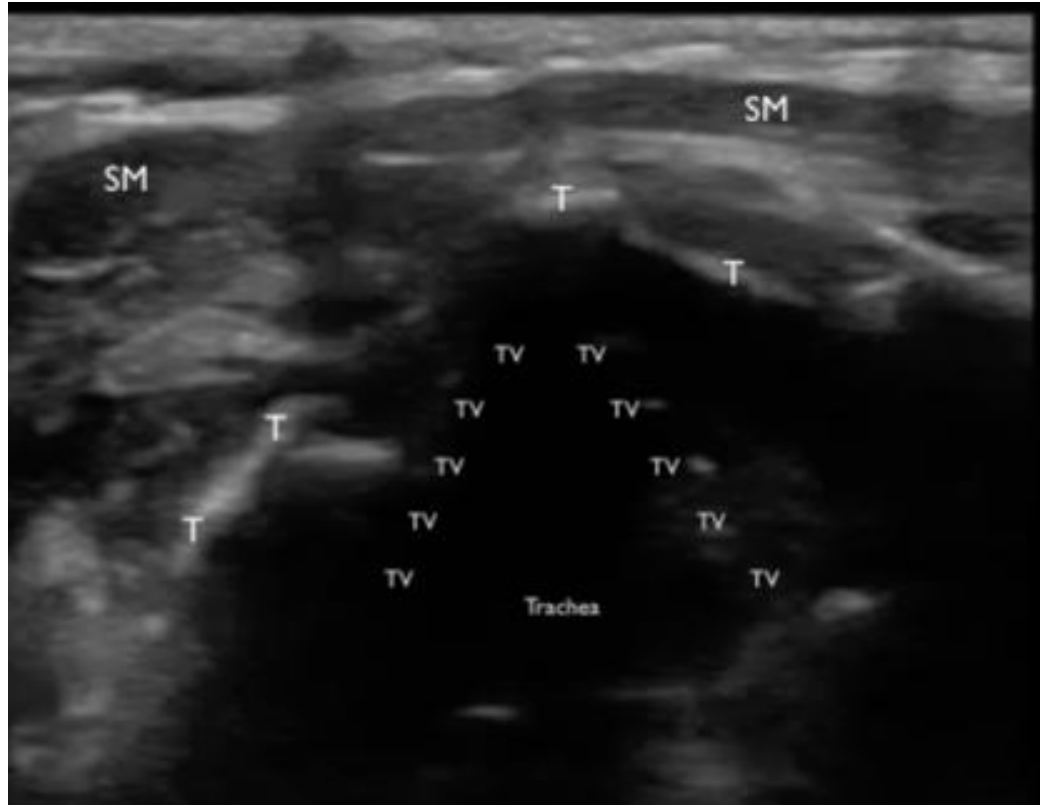
Figure 1. A transverse still image of the upper airway using the high frequency, linear transducer at the level of the true vocal cords (TV). Sternocleidomastoid muscles (SM) are seen anterior in the image. The true vocal cords appear as a linear structure that moves with phonations and is generally hypoechoic compared to the false vocal cords. The thyroid cartilage (T) appears hyperechoic in the image and provides a good acoustic window to visualize the vocal